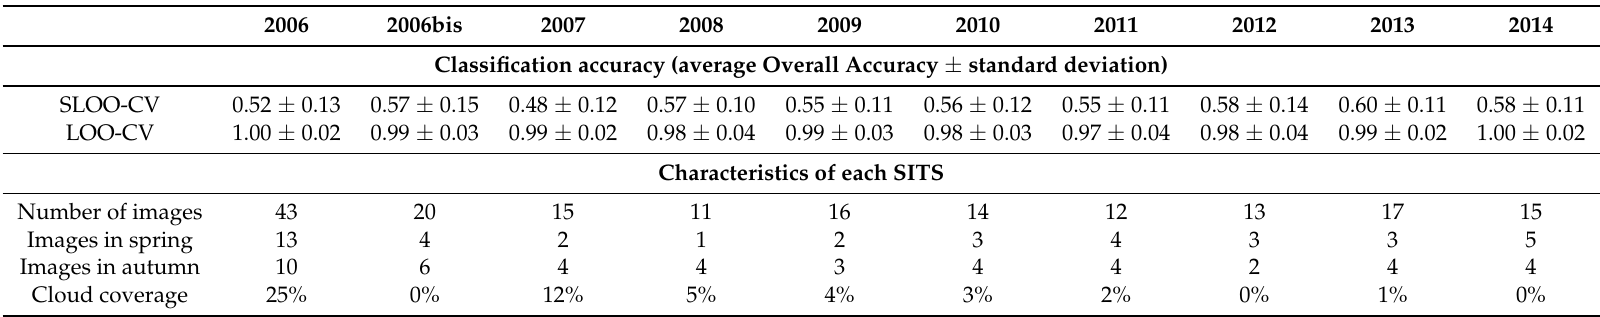
Table 2. Accuracy report of spatial leave-one-out cross-validation (SLOO-CV) sampling strategy and leave-one-out cross-validation (LOO-CV) for each single-year classification based on OA statistics. The 2006bis time series only includes cloud-free images of 2006. The average percentage of cloud coverage was estimated by computing for each species the number of time each reference sample was affected by clouds (detected from the MACCS processing